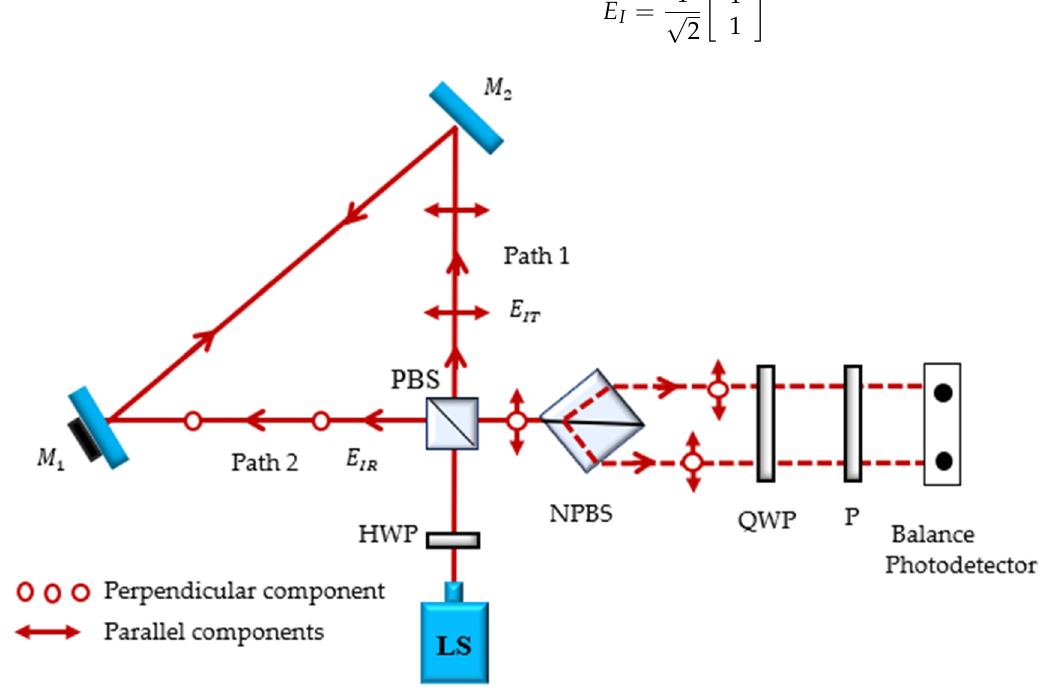
Figure 1. Schematic of the proposed modified Sagnac interferometer without sample. A polarization beam splitter (PBS) then divides the light into two beams, which are orthogonal and travel along pathways 1 and 2. Two mirrors ( 𝑀 (cid:2869) and 𝑀 (cid:2870) ) are used to re- flect the orthogonal beams, with 𝑀 (cid:2869) attached to a PZT. The PZT was driven by a piezo controller (Thorlabs: MDT694B, New Jersey, USA), which is precision, low-noise, and low- drift controller for piezo actuators. The intelligent-speed-control potentiometers on the front panel allow for precise setting of the output voltage over the full operating range.